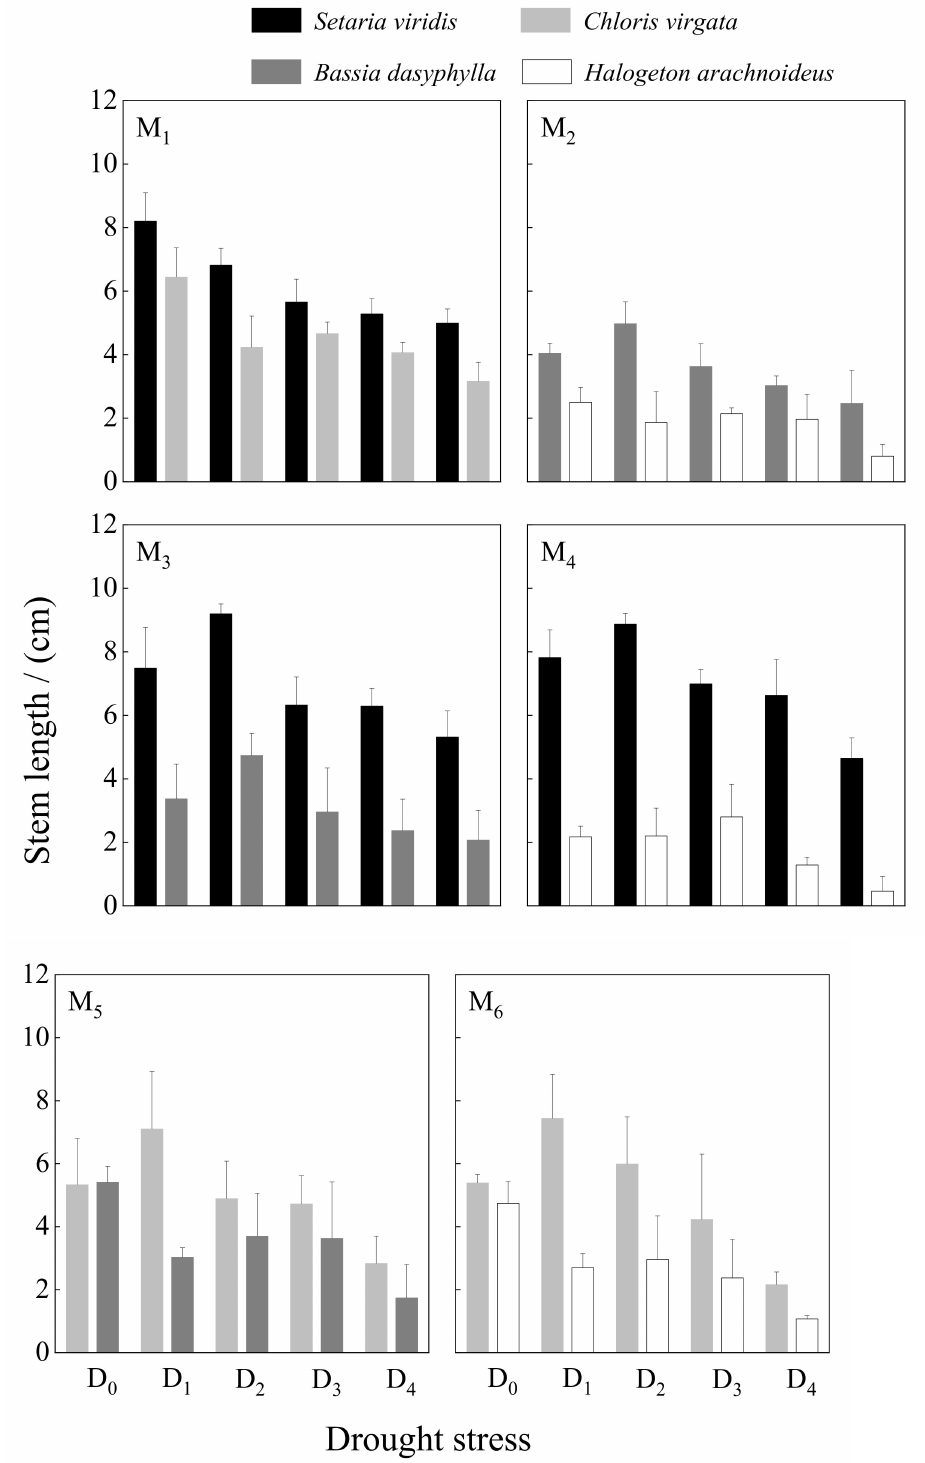
Figure 6. Response of stem length of four annual desert plants to the interaction of drought and mixed sowing (D0–D4 represents five drought stress gradients and D0–D4 represents PEG-6000 solution with different concentrations simulating different drought stress gradients, respectively: control 0% (D0), mild drought 2% (D1), moderate drought 5% (D2), moderate and high drought 10% (D3), and severe drought 15%